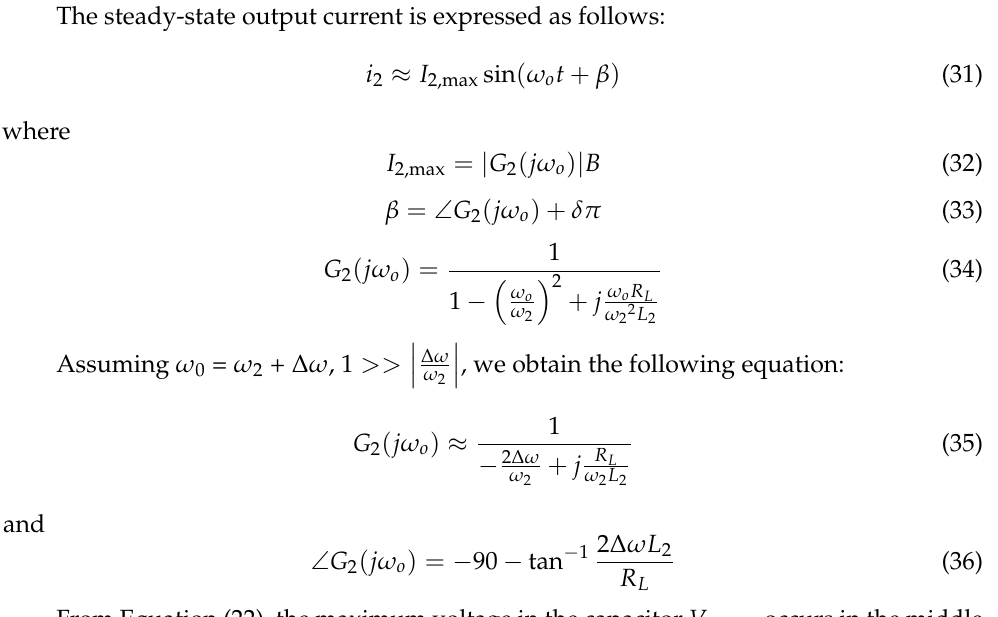
Figure 5. Excitation function to the impedance load side of the class-E